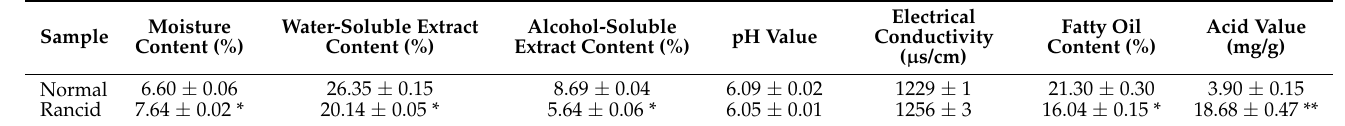
Table 2. The physicochemical characteristics of normal and rancid ZSS samples ( n =